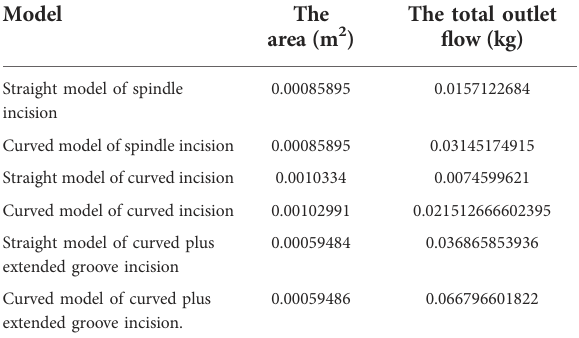
TABLE 7 The outlet area and outlet fl ow of different incision